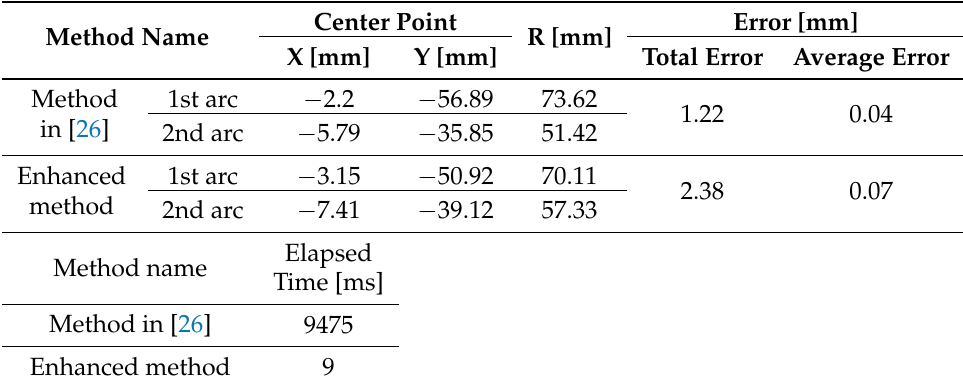
Table 2. A comparison of the enhanced piecewise arc curve fitting method with the piecewise arc curve fitting method from [26] (in total, 32 points).